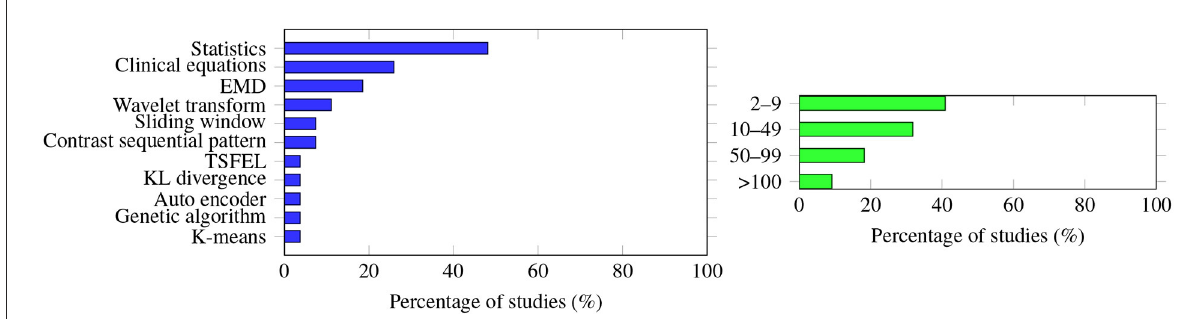
FIGURE4 (Left) The methodology used to extract the features was very diverse; no single methodology accounts for more than half of the studies. Statistics (e.g., maximum, minimum, mean values of the raw data) are the extracted features most often studied, followed by clinical equations (apply raw data to the equation to calculate some of the derived information, e.g., cardiac output, MAP to HR ratio). (Right) Graph showing how many features were extracted to predict AHE. The number varies greatly among the studies, with a single feature extraction being the most common.